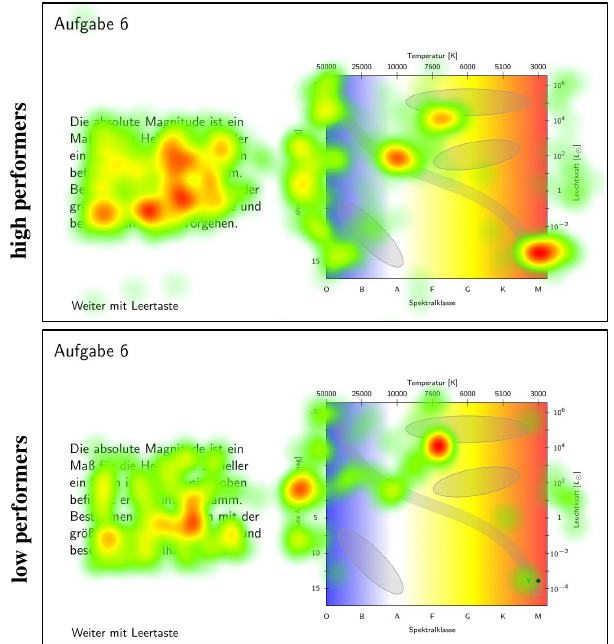
FIG. 11. Heat maps of all high performers (top) and all low performers (bottom) in comparison. The heat maps show the visual attention when solving item T6 as originally used in the study (English translations can be found in the Supplemental Material [51]). Here, three stars are given, and the problem requires comparing their magnitude values to identify the brightest one (bottom (cid:129) During problem solving, low performers fixated less along the entire magnitude axis and considered only its upper region. However, the high performers fixated on the entire axis and were thus able to identify the star they were looking for (highest magnitude) as the lowest in the diagram.